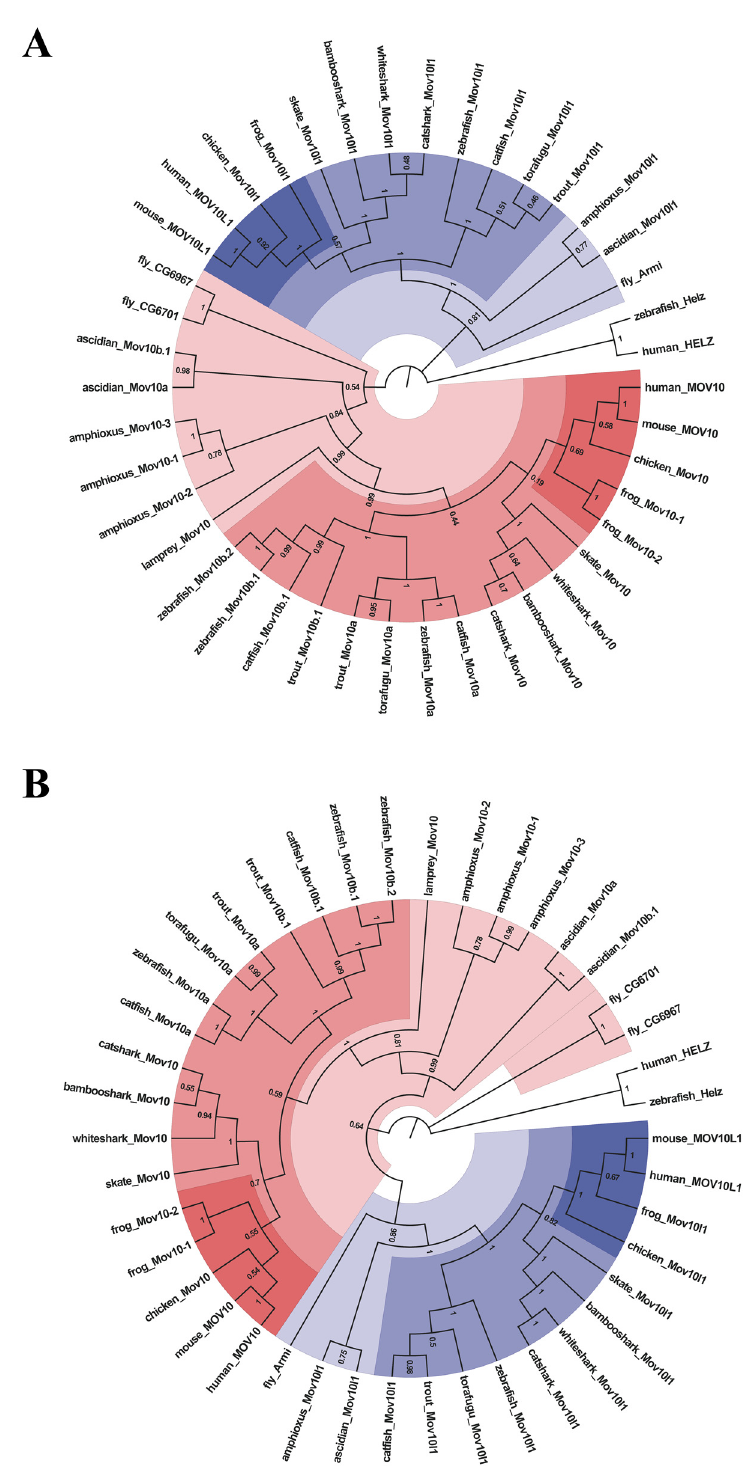
Figure 2. Phylogenetic tree analysis of the MOV10 and MOV10L1 in the selected species above. They are constructed by Maximum-Likelihood method ( A ) and Neighbor-Joining method ( B ). Different colored areas represent different evolutionary status, with darker colors indicating higher evolution- ary status. Numbers at each branches mean the percentage of replicate trees in which the associated taxa clustered together in the bootstrap test (1000 replicates). Both trees are rooted with human and zebrafish helz.